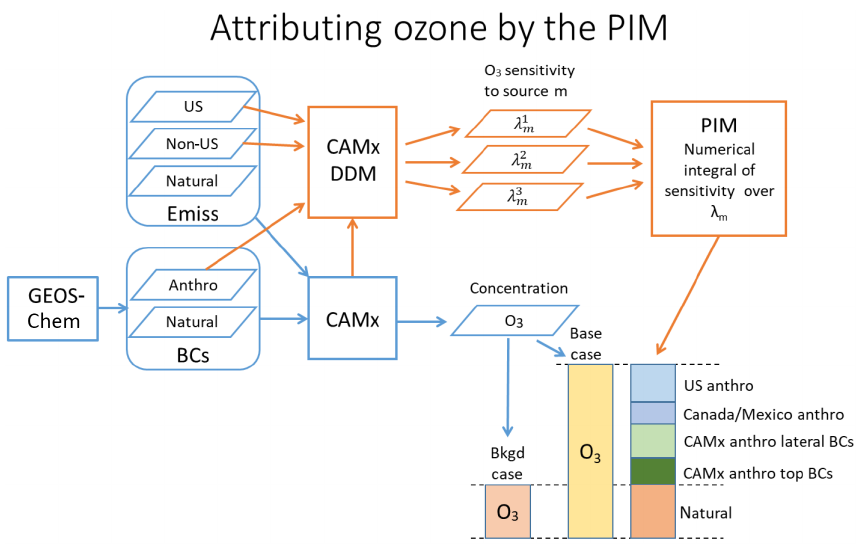
Figure 2. Schematic diagram of source apportionment by the path-integral method (PIM). Two worldwide GEOS-Chem simulations with and without anthropogenic emissions provide boundary concentrations (BCs) for the corresponding CAMx simulations. Two CAMx simulations with and without anthropogenic emissions give the base and background cases for North America. Three CAMx simulations using the decoupled direct method (DDM) provide the O 3 sensitivity to source category m for emissions and BCs scaled between the base and background cases by factors λ 1 m , λ 2 m , and λ 3 m . Numerical integration using the sensitivities at λ 1 m , λ 2 m , and λ 3 m gives the contribution of source m to the anthropogenic increment to O 3 (base minus background cases). Blue boxes and arrows indicate information flow for CAMx; orange boxes and arrows indicate information flow for the